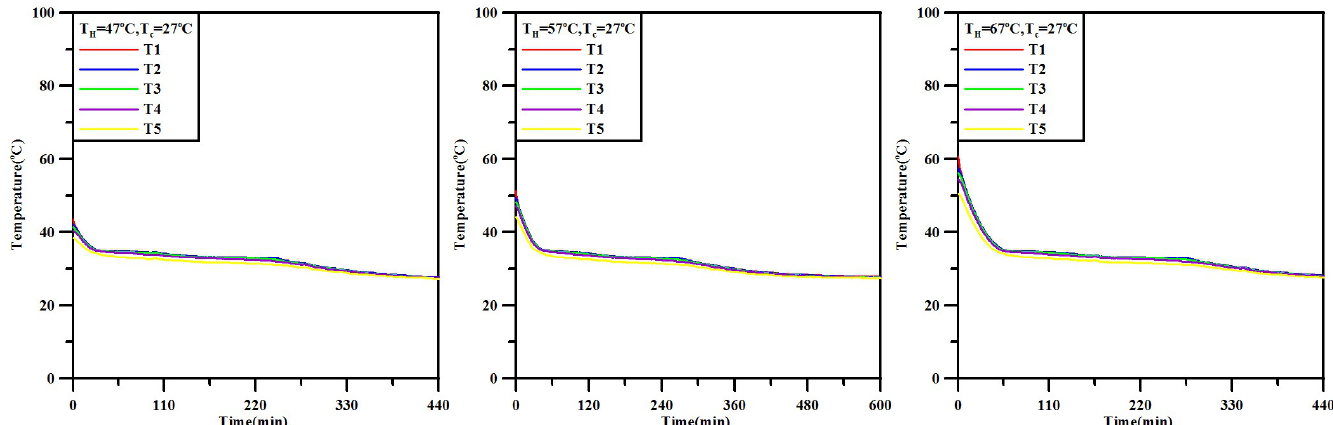
Figure 6. The solidification interface location (melting fraction) and the interior temperature of the mPCM as a function of time at T C = 27 °C after the heat supply was stopped (initial hot wall temperature T H ).